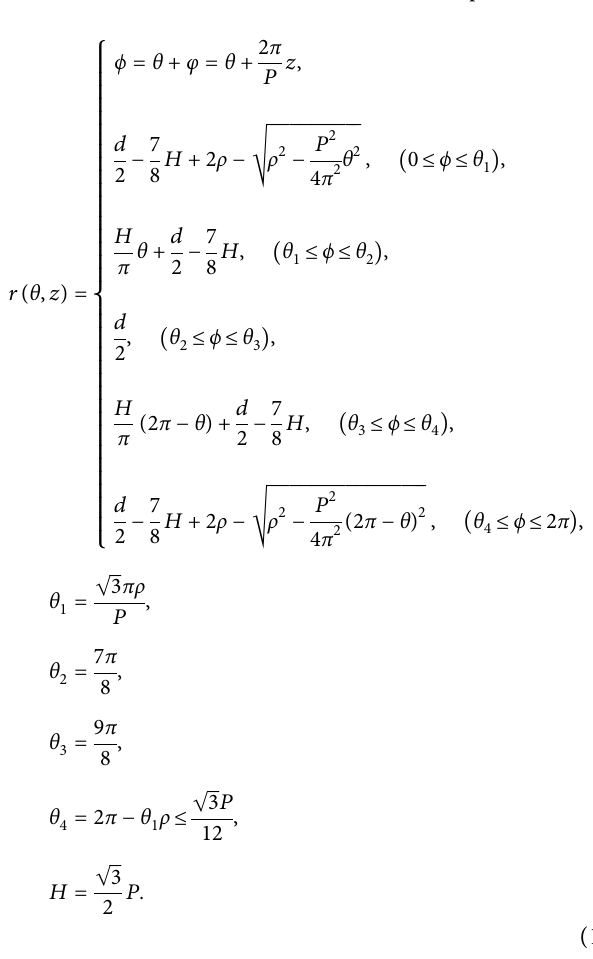
Figure 6: The section profile of the external thread and along the bolt axis